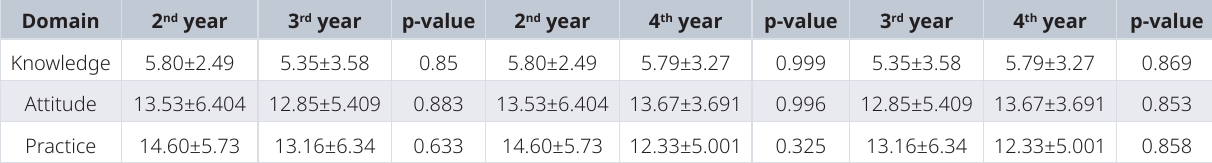
Table 7. ANOVA test results for knowledge, attitude, and practice comparisons between students.